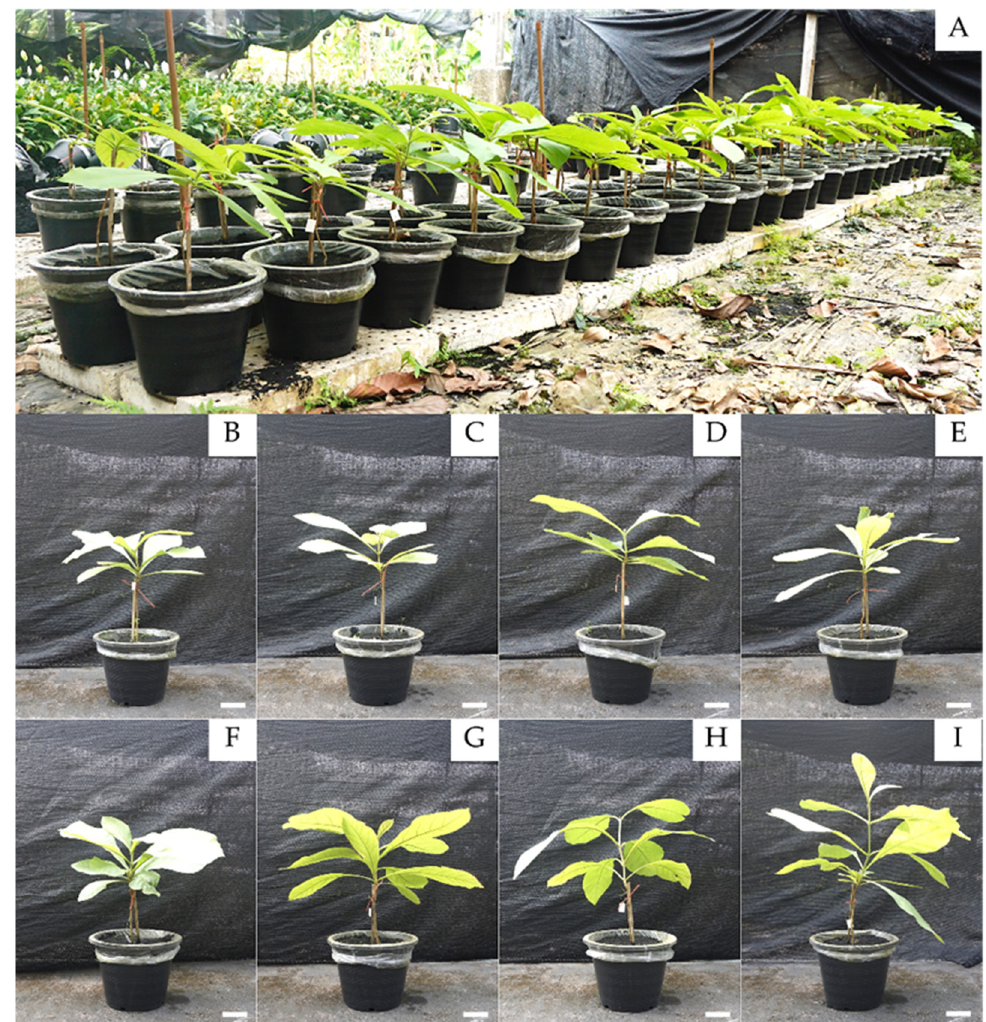
Figure 1. Establishment of pot experiments for assessing plant-growth-promoting activity of teak rhizosphere microbes. Pot experiments were conducted under greenhouse conditions ( A ). A comparison of representative plant physiology derived from different treatments at the end of pot experiments ( B – I ). The treatments include teak seedlings grown in planting materials non-inoculated (control, B ) and inoculated with different rhizosphere microbes, i.e., with nitrogen-fixing bacterium isolate CGC-5 ( C ), with actinobacterium isolate TCM1-050 ( D ), with isolates CGC-5 and TCM1-050 ( E ), with arbuscular mycorrhizal fungus, Claroideoglomus isolate PBT03 ( F ), with isolates CGC-5 and PBT03 ( G ), with isolates TCM1-050 and PBT03 ( H ), and with every tested microbial isolate ( I ). Scale bars = 7 cm. The nitrogen-fixing bacterium isolate CGC-5 was grown in nutrient broth (Difco TM , USA) on a reciprocal shaker (120 rpm) at 27 °C for two days. Its cells were collected by centrifugation at 6693 × g for 5 min and resuspended in sterile distilled water. The cell density was adjusted to 10 8 colony forming units (CFUs) mL − 1 using sterile distilled water and counting with a hemocytometer (HBG, Giessen, Germany) under a light microscope (Olympus CH30, Tokyo, Japan). The actinobacterium isolate TCM1-050 was grown on ISP3 agar medium [29] at 30 ◦ C for 14 days. Its cells and spores were collected by flooding the seeded agar plate with sterile distilled water containing tween 80 (a drop of tween 80 per 500 mL water) and adjusted to 10 6 spores mL − 1 using the hemocytometer-based method mentioned above. For the arbuscular mycorrhizal fungus, spores of Claroideoglomus sp. PBT03 were propagated and quantified as described previously. A spore density at 50 fun- gal spores per g of planting materials was measured and prepared as the fungal